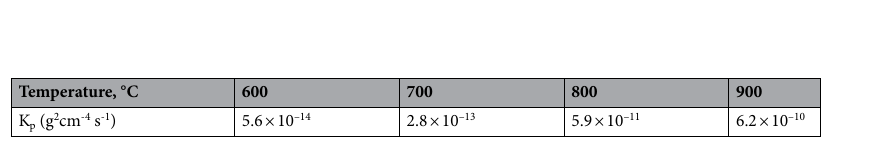
Table 1. Parabolic constant values of oxidation rate K p at various temperature.